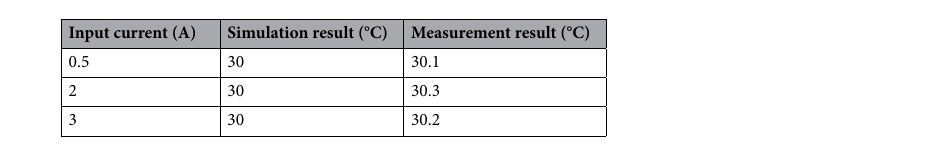
Table 3. Comparison of simulation results and experimental results at different input currents.